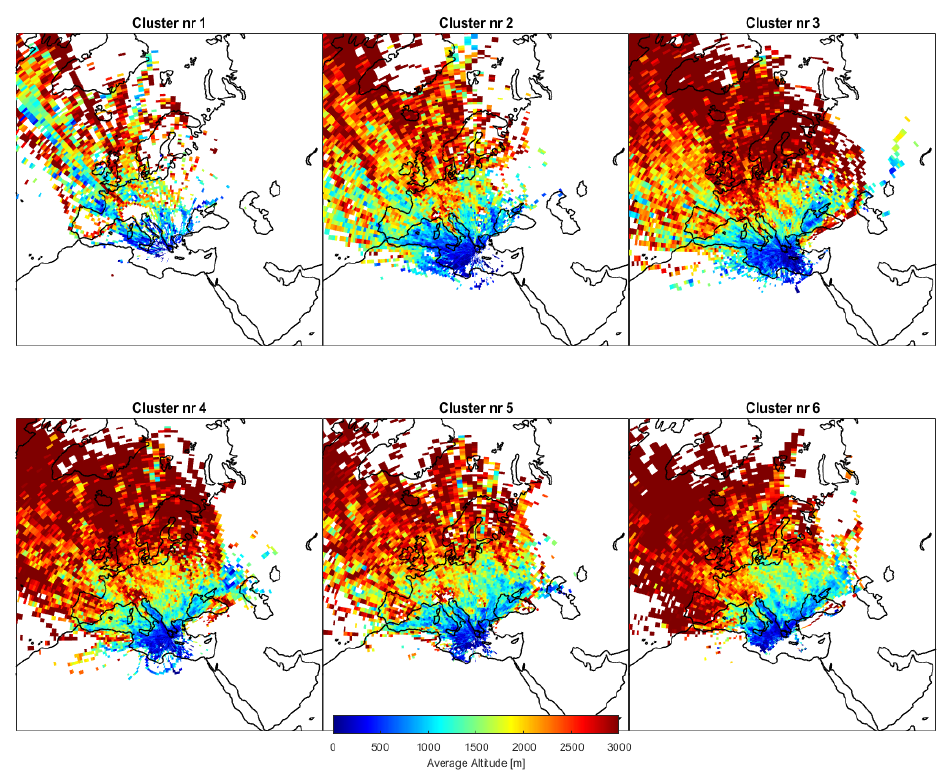
Figure 15. Average altitude for the transport path of the air mass related to cluster 1–6.